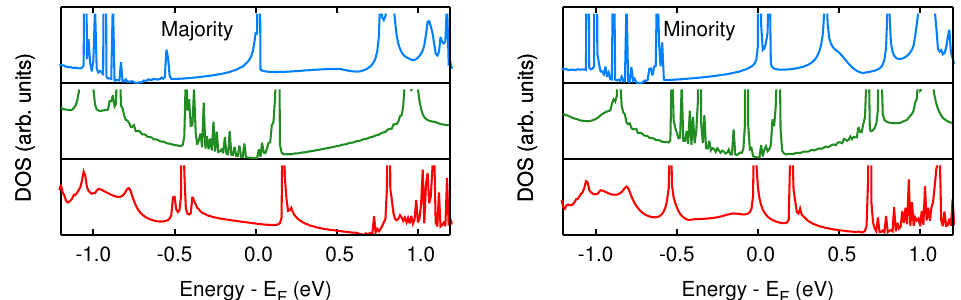
Figure 6. DOS of the nanojunction with undoped (green) and doped electrodes (B in red, N in blue).